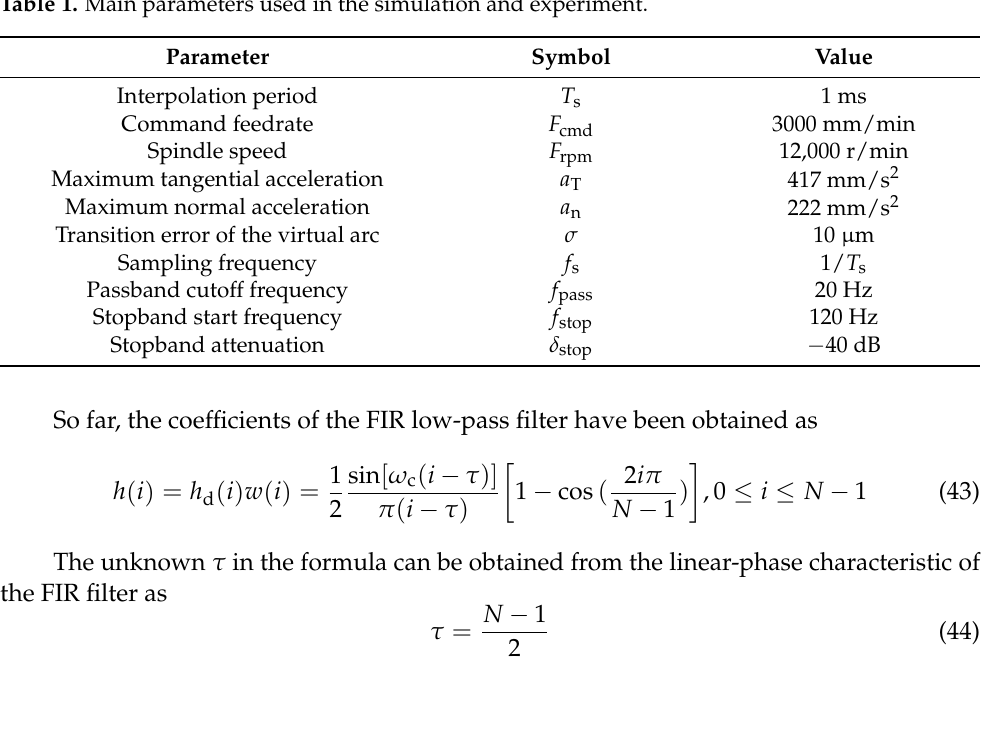
Table 1. Main parameters used in the simulation and